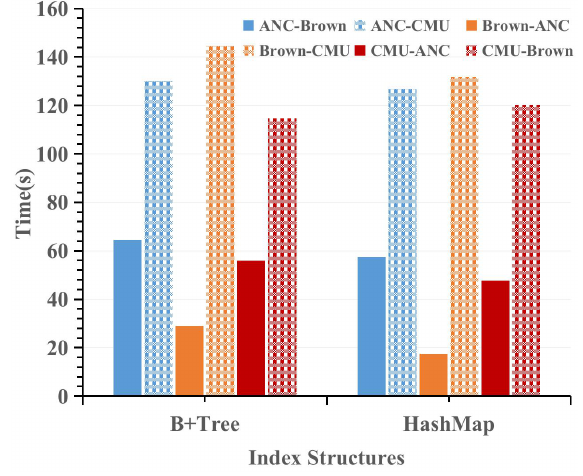
Figure 14. Comparison of the time of version merge between B+Tree and